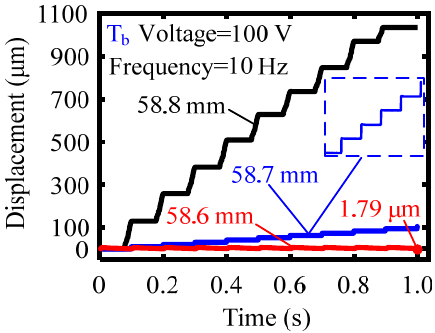
Figure 9. Output displacement of the actuator obtained with various working gaps. The driving voltage and frequency are 100 V and 10 Hz, respectively.